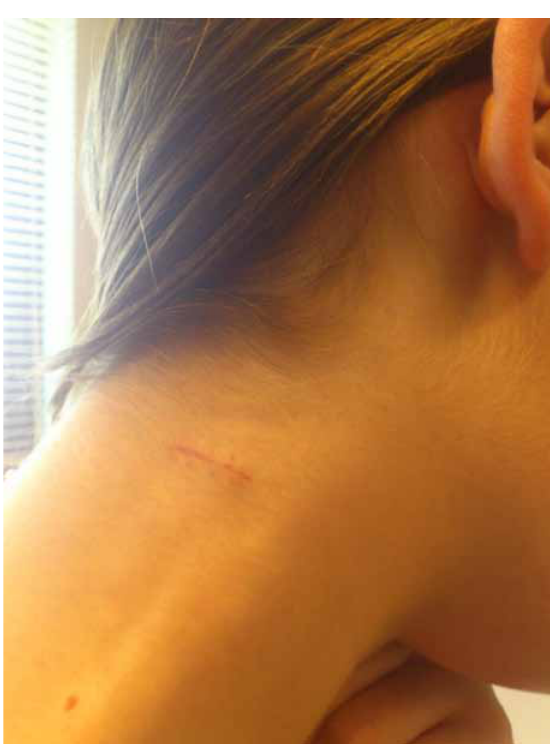
Figure 1. Painful right linear neck lymphadenopathy.